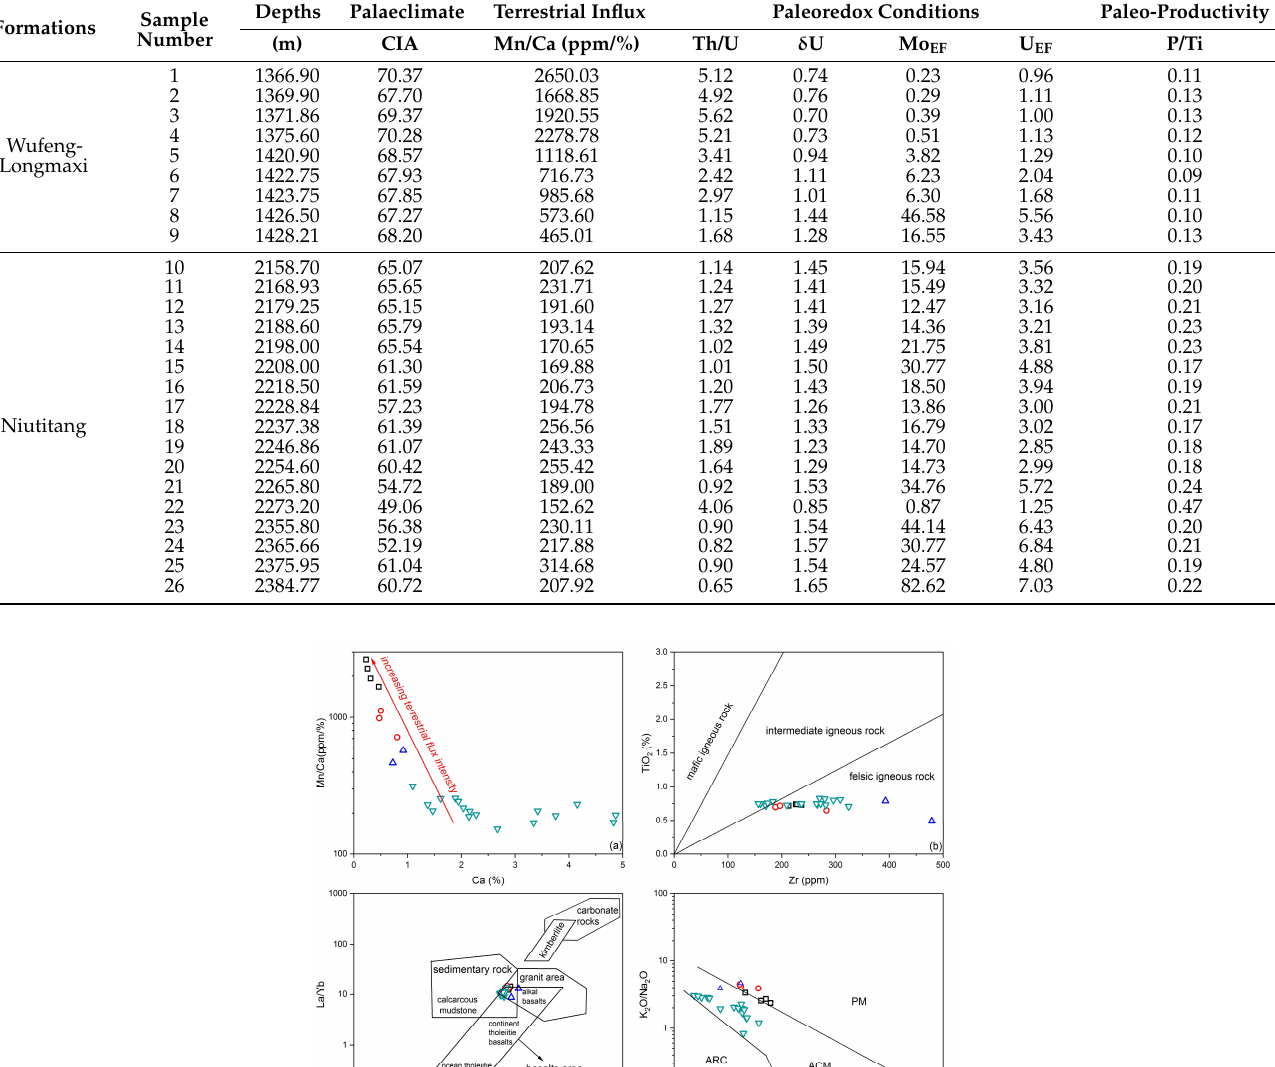
Table 5. Geochemical proxies of the Wufeng-Longmaxi and Niutitang samples.